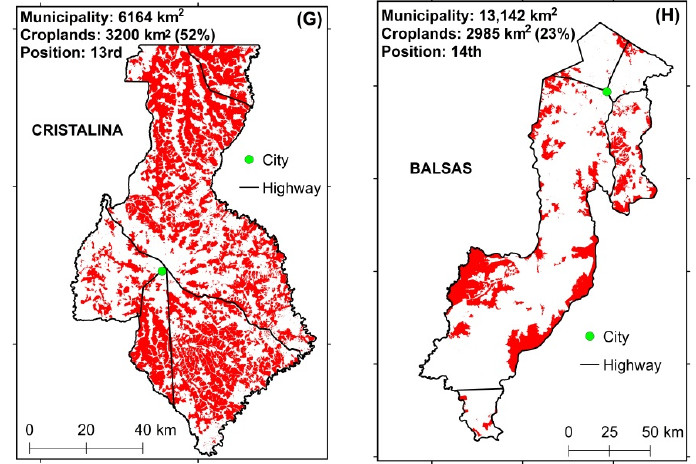
Figure 4. Areas with annual and perennial crops in 2018 (in red) in the municipalities of Sapezal, Mato Grosso State ( A ), Rio Verde, Goiás State ( B ), São Desidério, Bahia State ( C ), Maracaju, Mato Grosso do Sul State ( D ), Formosa do Rio Preto, Bahia State ( E ), Primavera do Leste, Mato Grosso State ( F ), Cristalina, Goiás State ( G ), and Balsas, Maranhão State ( H ). Source: [58]. In the Maracaju municipality, the area of croplands is larger than the area of municipality probably because of the double cropping system.